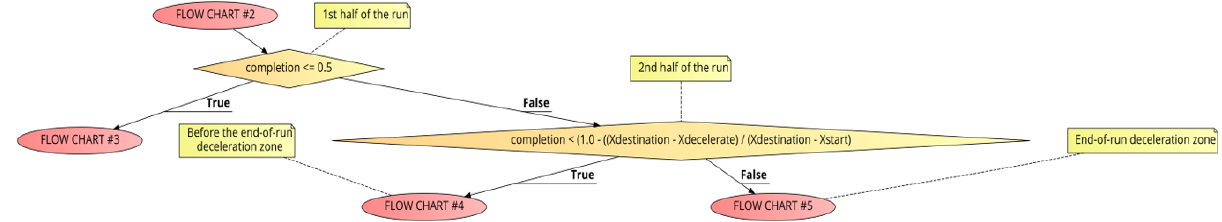
Figure 9. PID++ Flow Chart #2—completion control level.